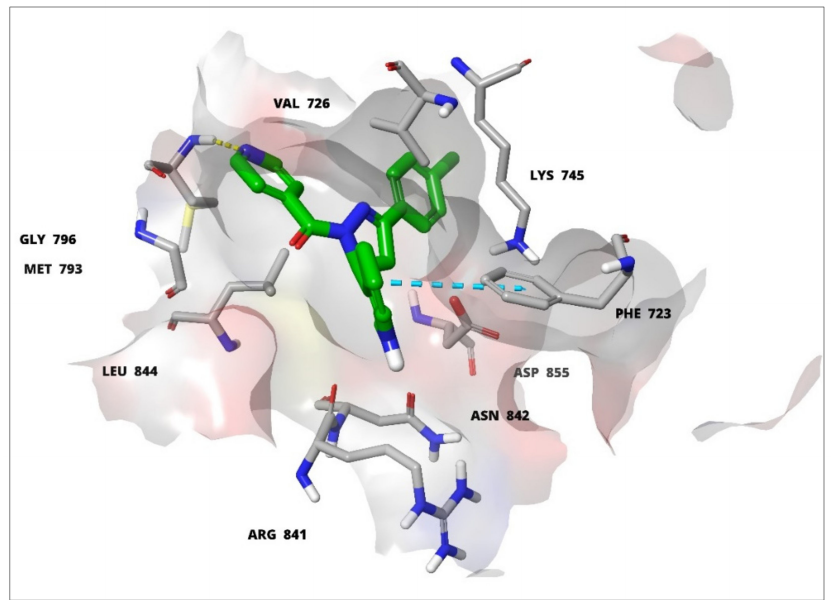
Figure 3. Ligand binding: 3D overlay of the compound HD05 with the active site of EGFR-TK.